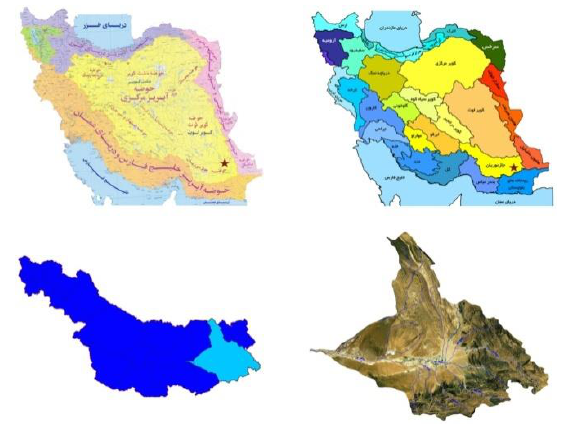
Figure 2. Geographical position of Iranshahr catchment